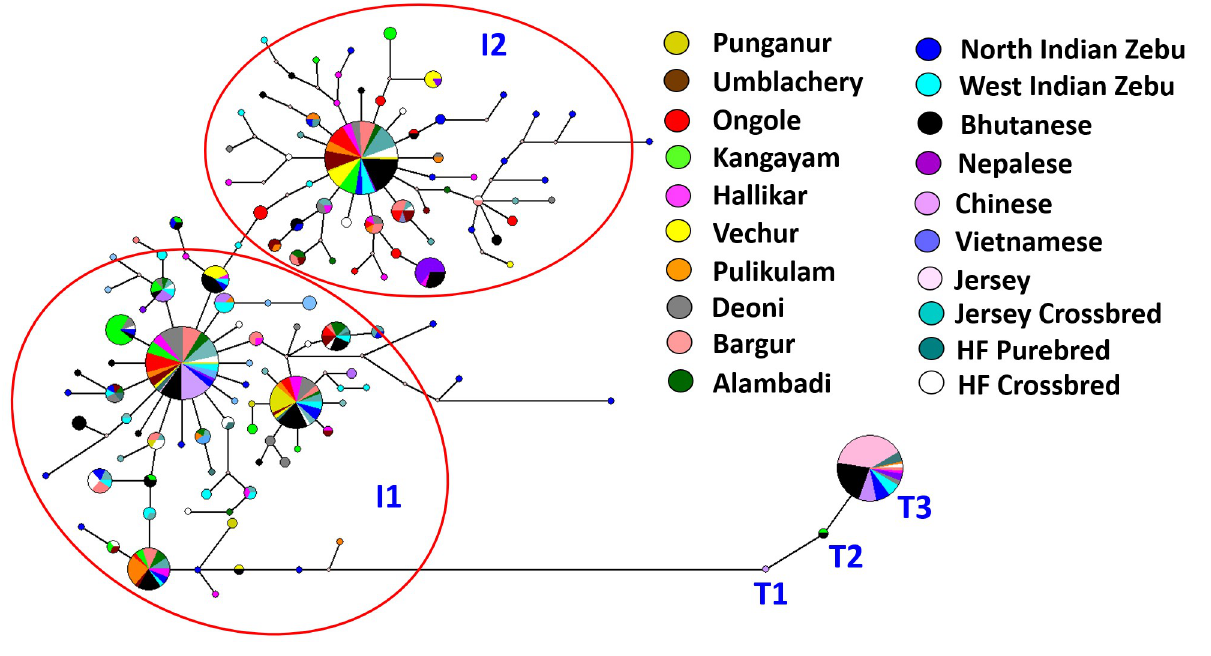
Fig 7. Median joining network of mtDNA control region haplotypes of draught type zebu, taurine and crossbred cattle from South India and Zebu cattle from China, Nepal, Vietnam, North India, West India (size of the circle indicates frequency of